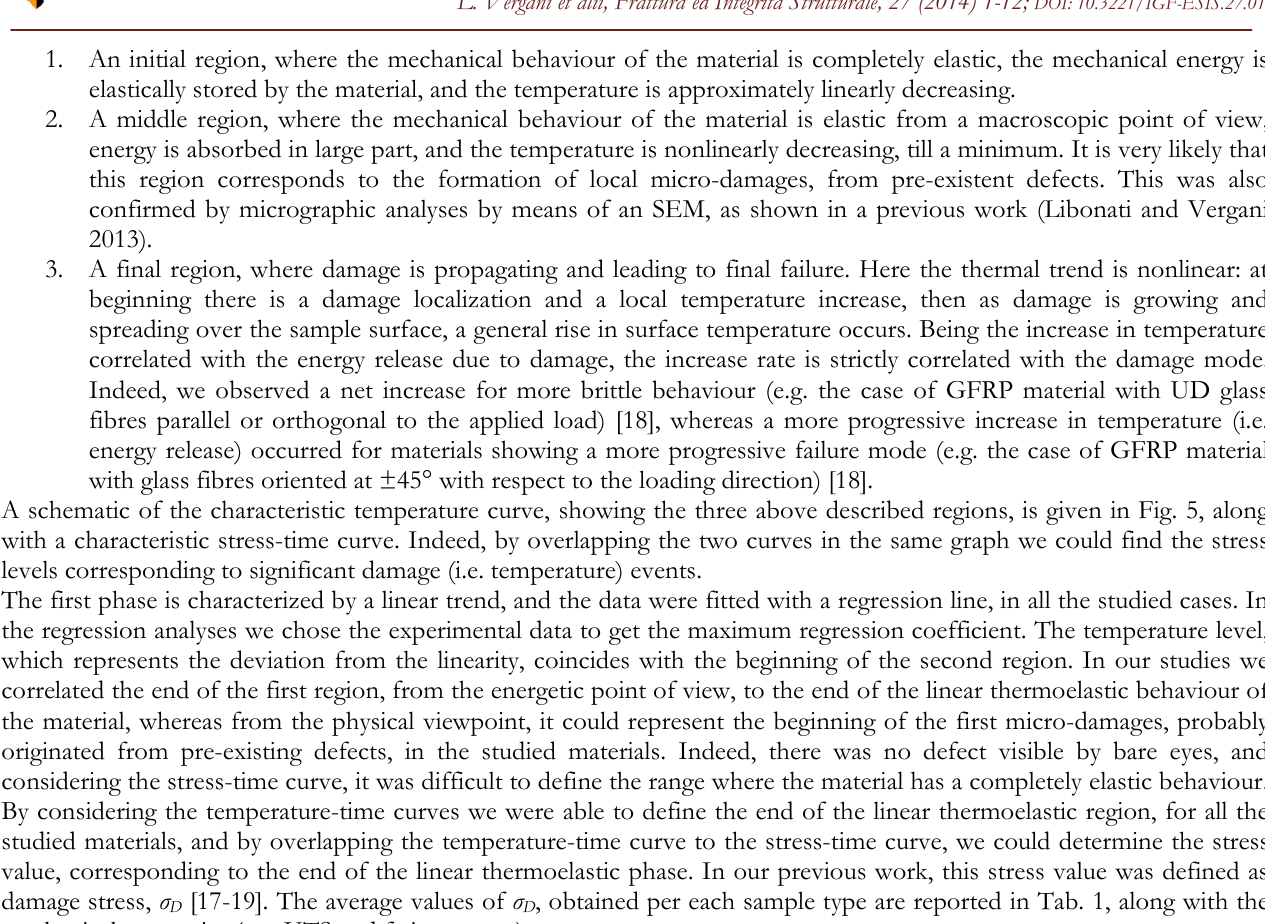
, which corresponds D and σ are highlighted, the former corresponding to II III